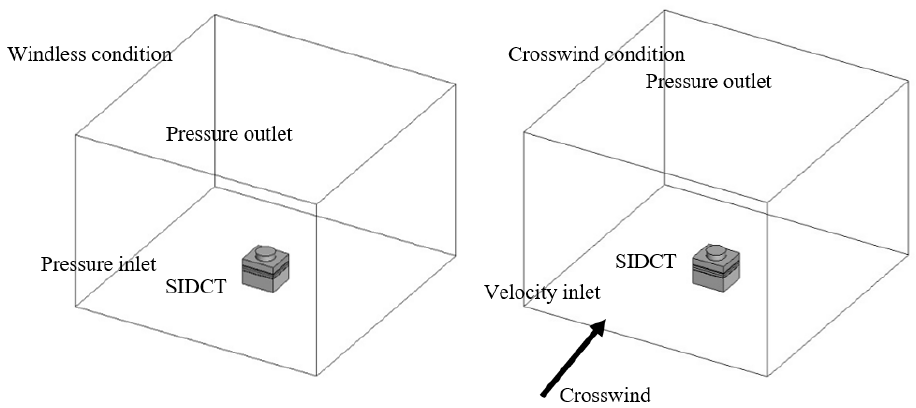
Figure 5. Simulation domain and boundary